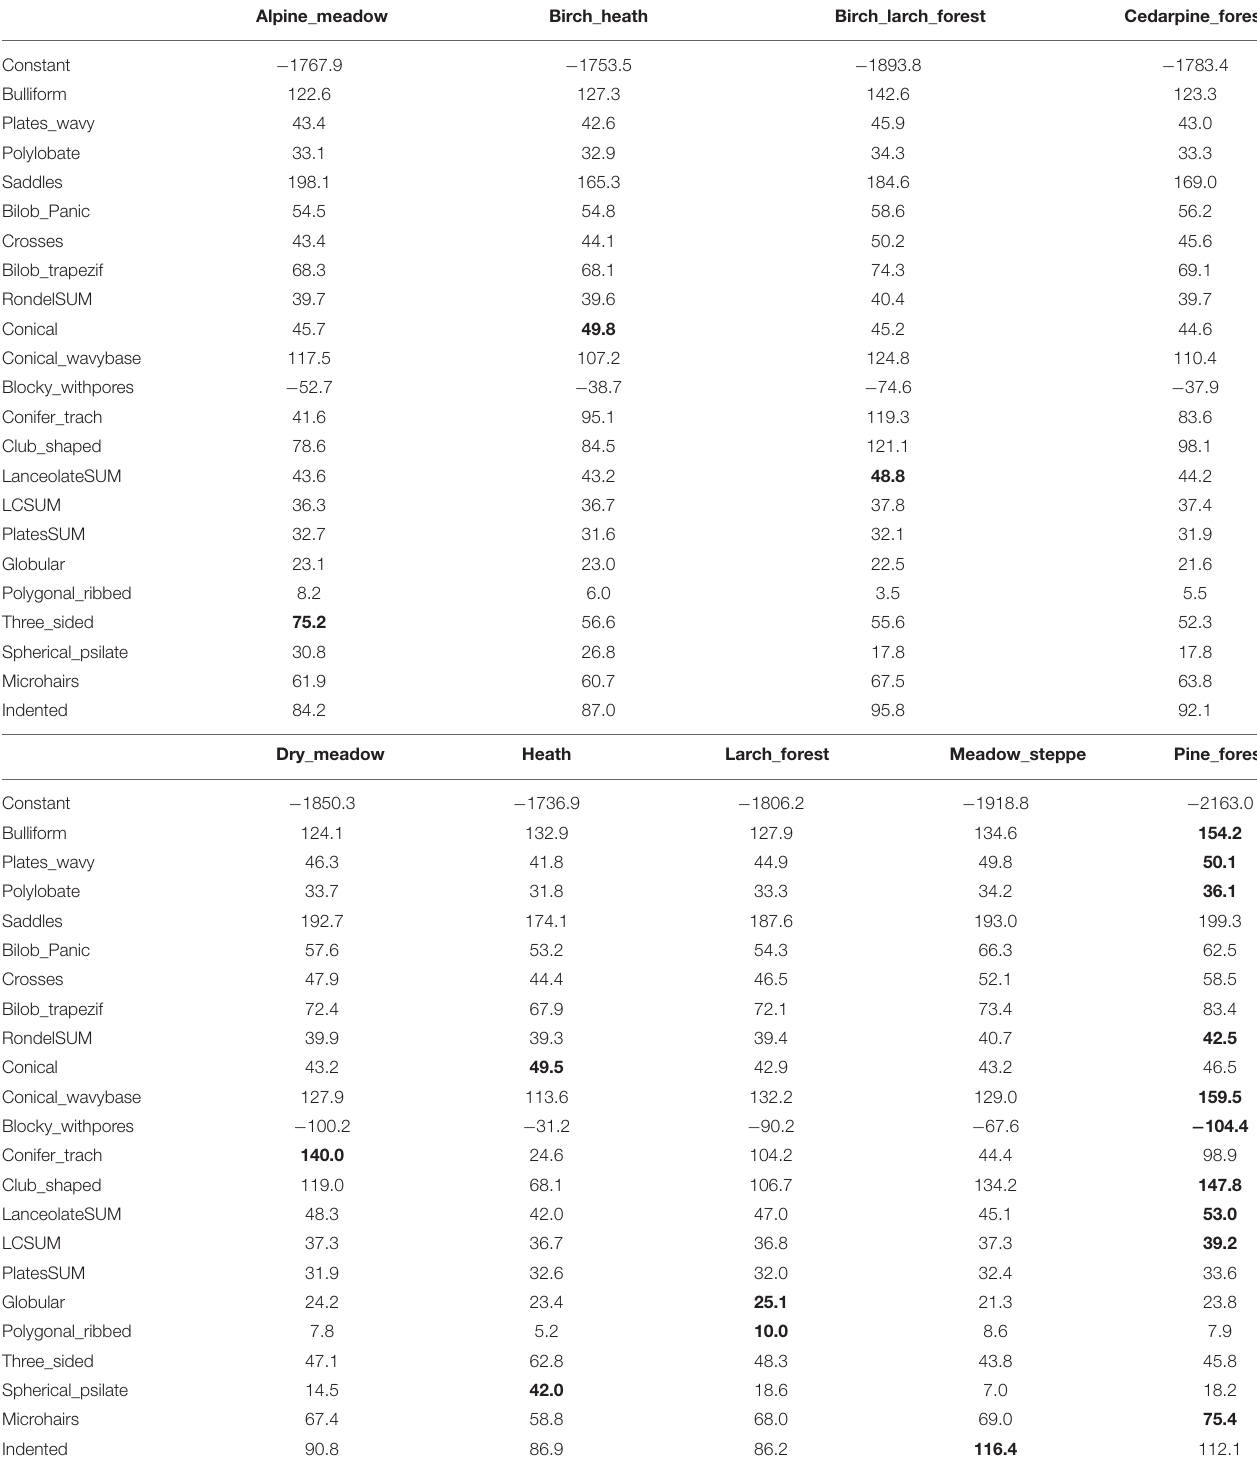
TABLE 3 | Results of discriminant analysis showing linear discriminant function for groups (highest score in each community for each morphotype is shown in bold).